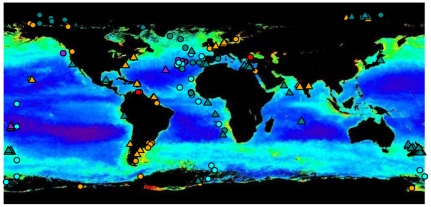
Global map of sample locations.Sample locations were plotted on a SeaWiFS satellite image of chlorophyll pigment concentration, with redder colour representing higher concentrations. The realm origin of the samples is indicated by circles (pelagic) and triangles (benthic), whereas ecosystem types are indicated by the colour orange (coastal), light blue (open ocean surface waters), dark blue (deep-sea), red (anoxic), and purple (hydrothermal vents). Further visualization of sample distribution e.g. on a bathymetric map is available at http://vamps.mbl.edu/mapper/index.php.